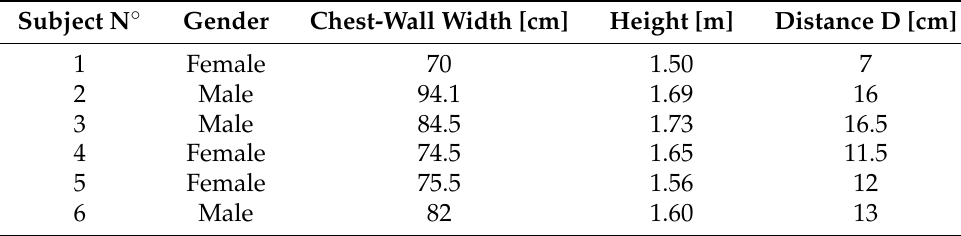
Table 4. Physical description of the subjects under